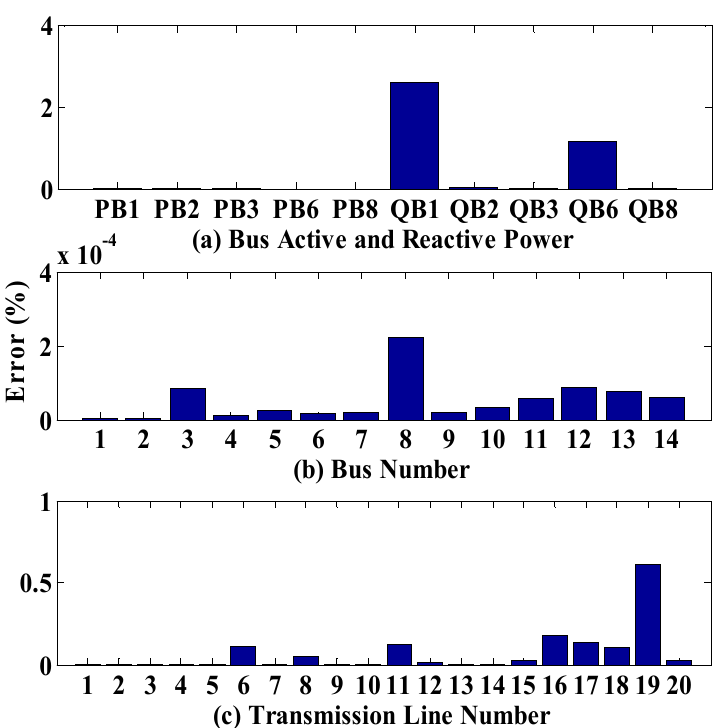
Figure 4. Mean Squared Error: ( a ) Active and Reactive Power on Generator Busses; ( b ) Bus Voltages; ( c ) Transmission Line Loading.